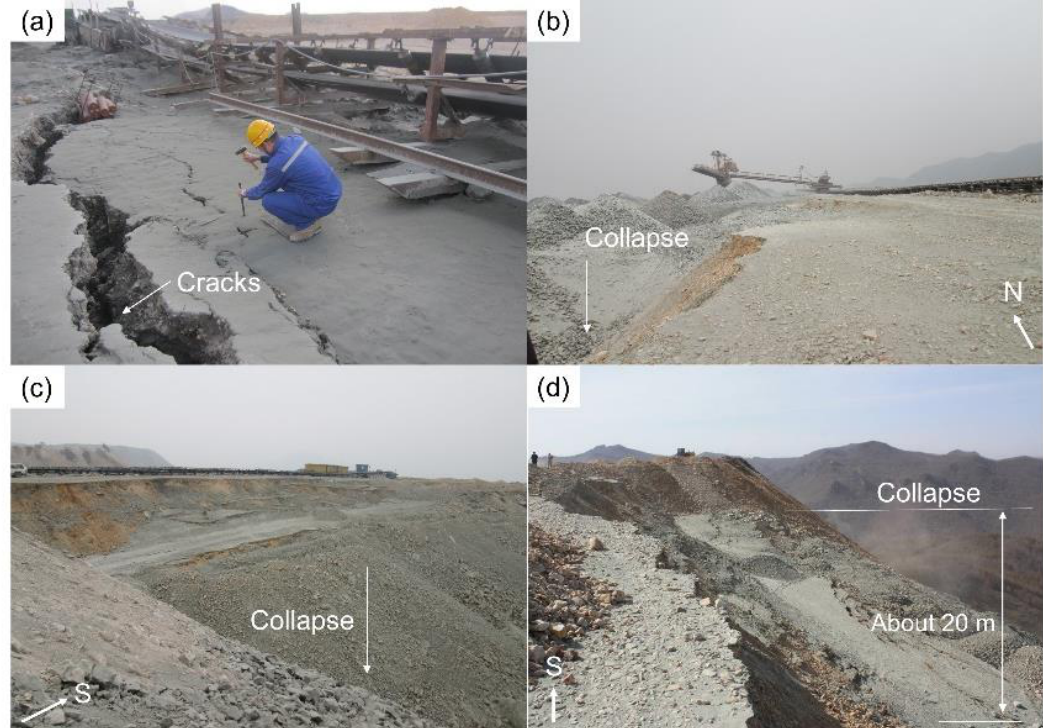
Figure 4. Cracks and collapses (critical stage): ( a ) cracks; ( b – d ) collapse.